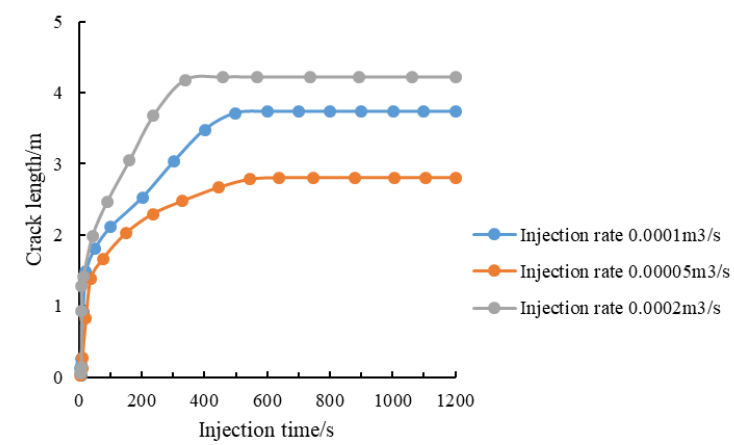
Figure 11. The relationship between crack length and injection time under different injection rates.